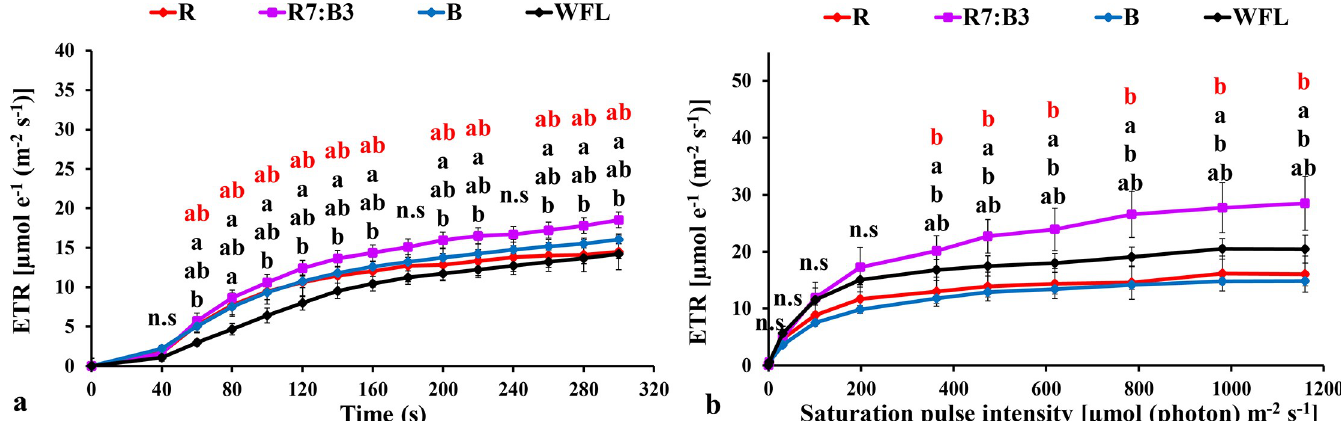
Fig 6. Effects of LED light quality on chlorophyll a fluorescence induction kinetics of dark-acclimated ( a ) and RLC of the light-acclimated ( b ) electron transport rate (ETR) in grafted tomato leaves. Similar letters indicate non-significant difference among treatments according to DMRT at P � 0.05. Vertical bars indicate average ± standard error (4 replicates). According to the treatments, sort significance letters from top to bottom (R, R7:B3, B, WFL). Where R = Red light 100%, R7: B3 = Red70%+ Blue30%, B = Blue light 100%, WFL = White Fluorescent